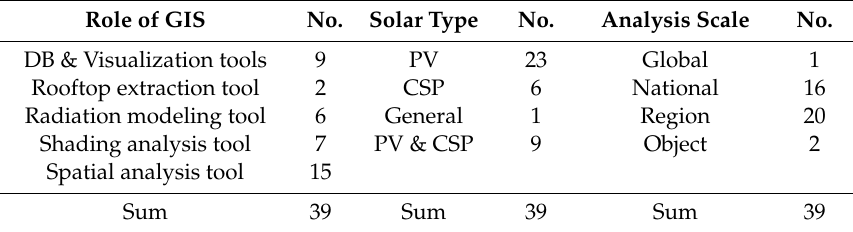
Table 3. Classification and number of articles according to the role of the GIS, solar type, or scale. Role of GIS No. Solar Type No. Analysis Scale No. DB & Visualization tools 9 PV 23 Global 1 Rooftop extraction tool 2